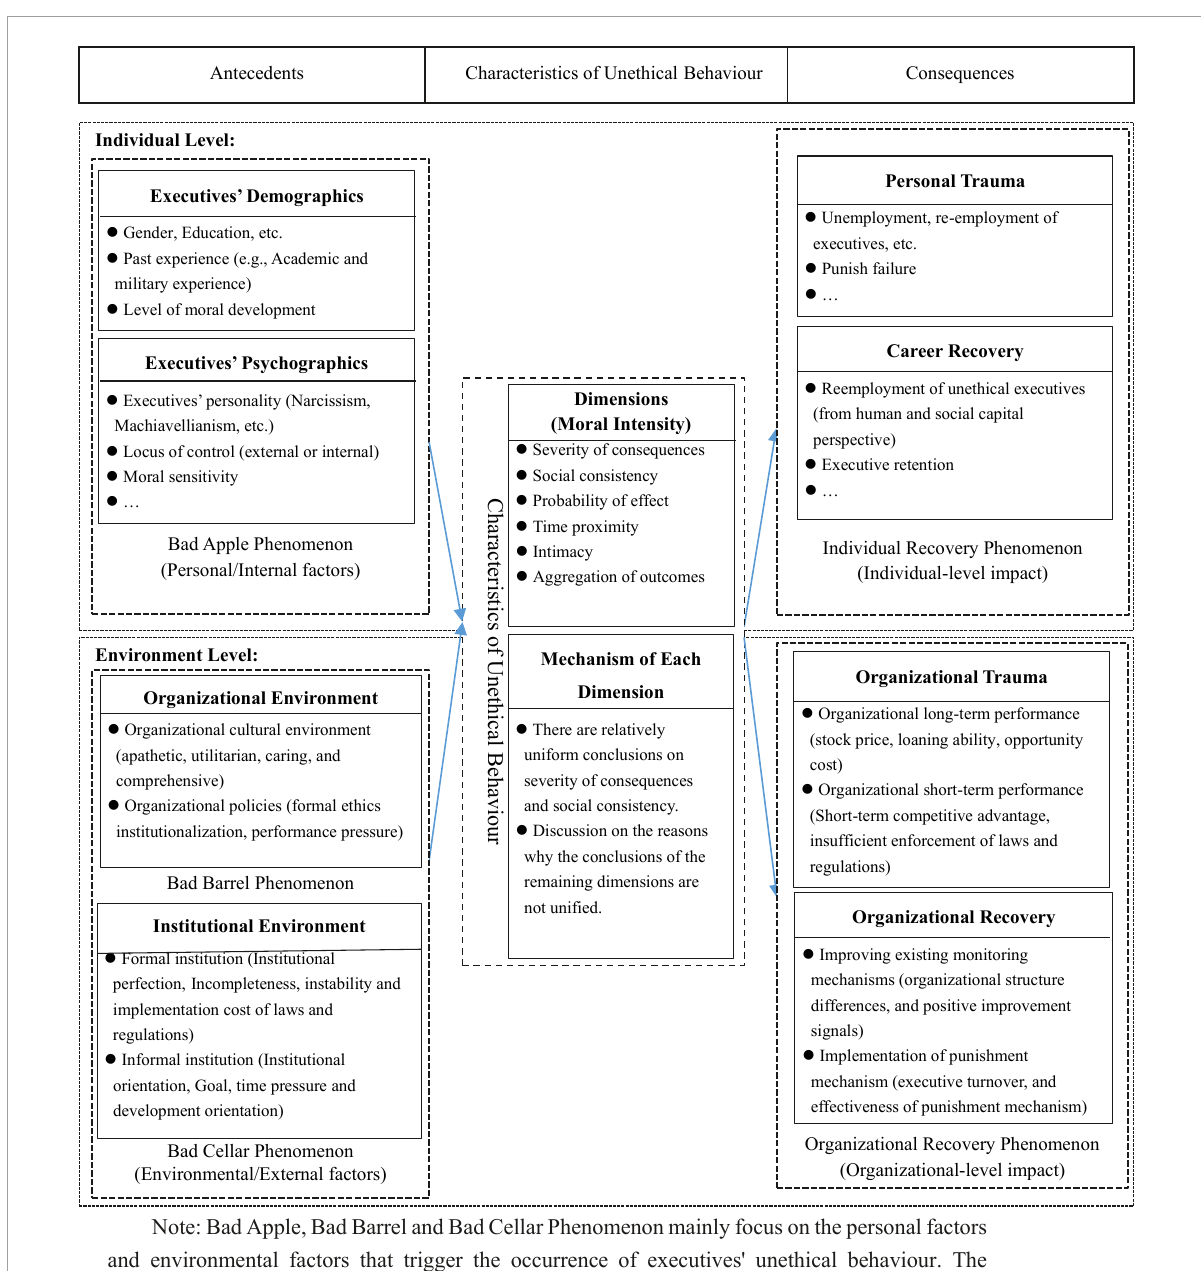
FIGURE4 The conceptual framework for executives’ unethical behaviour.